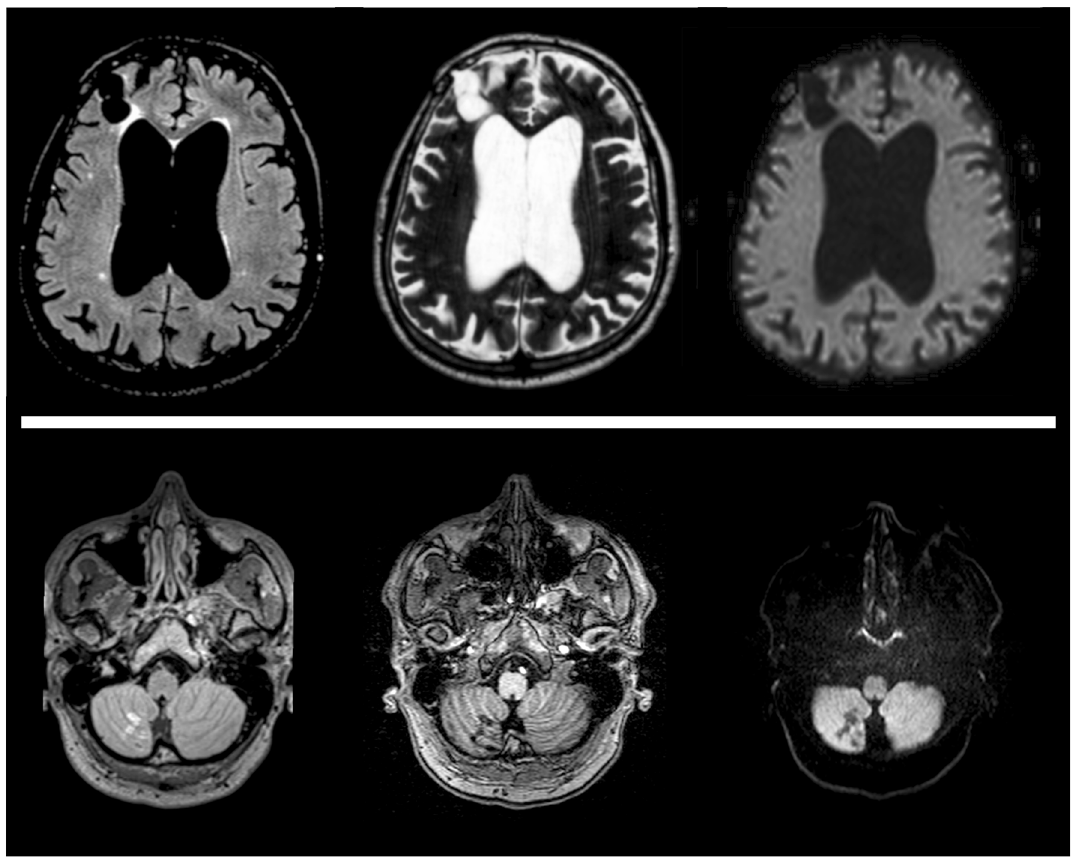
Fig. 1 Brain MRI findings in Fabry disease patients suffering from major cerebrovascular events. In the upper row , images obtained from a 61- year-old woman showing the presence of a large chronic ischaemic lesion at the level of the right frontal lobe, coupled to a significant enlargement